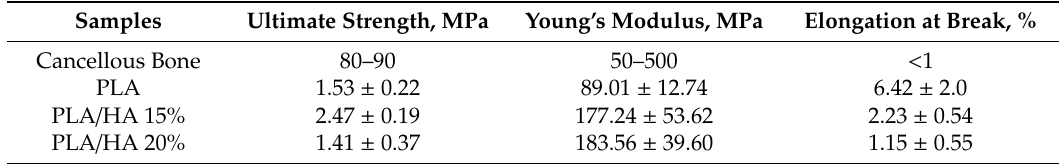
Table 1. Values of ultimate strength, Young’s modulus, and elongation at break obtained